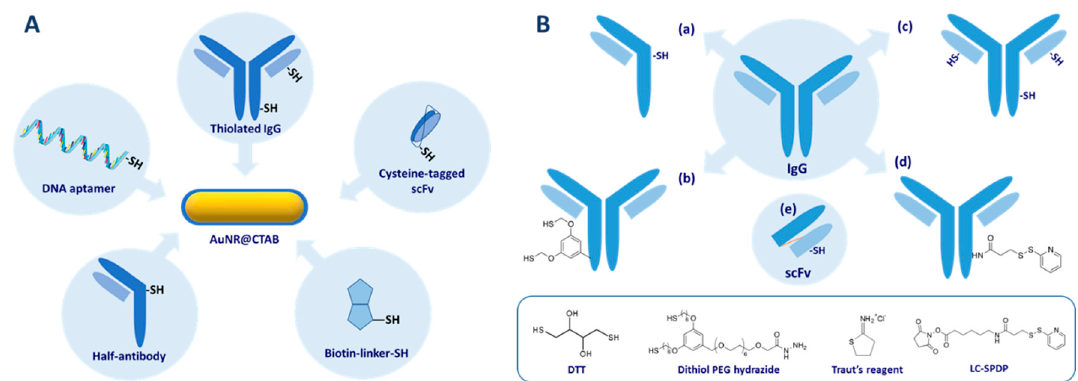
Figure 16. ( A ) Chemisorption of various thiol-containing biomolecules to CTAB-capped AuNR. ( B ) Introduction of thiol groups on IgG-type antibodies, ( a–d ), starting from an IgG using: ( a ) DTT (dithiotreitol); ( b ) NaIO 4 then dithiol PEG hydrazide; ( c ) Traut’s reagent; ( d ) N-Succinimidyl-6-(3’-(2- PyridylDithio)-Propionamido)-hexanoate (LC-SPDP); and ( e )